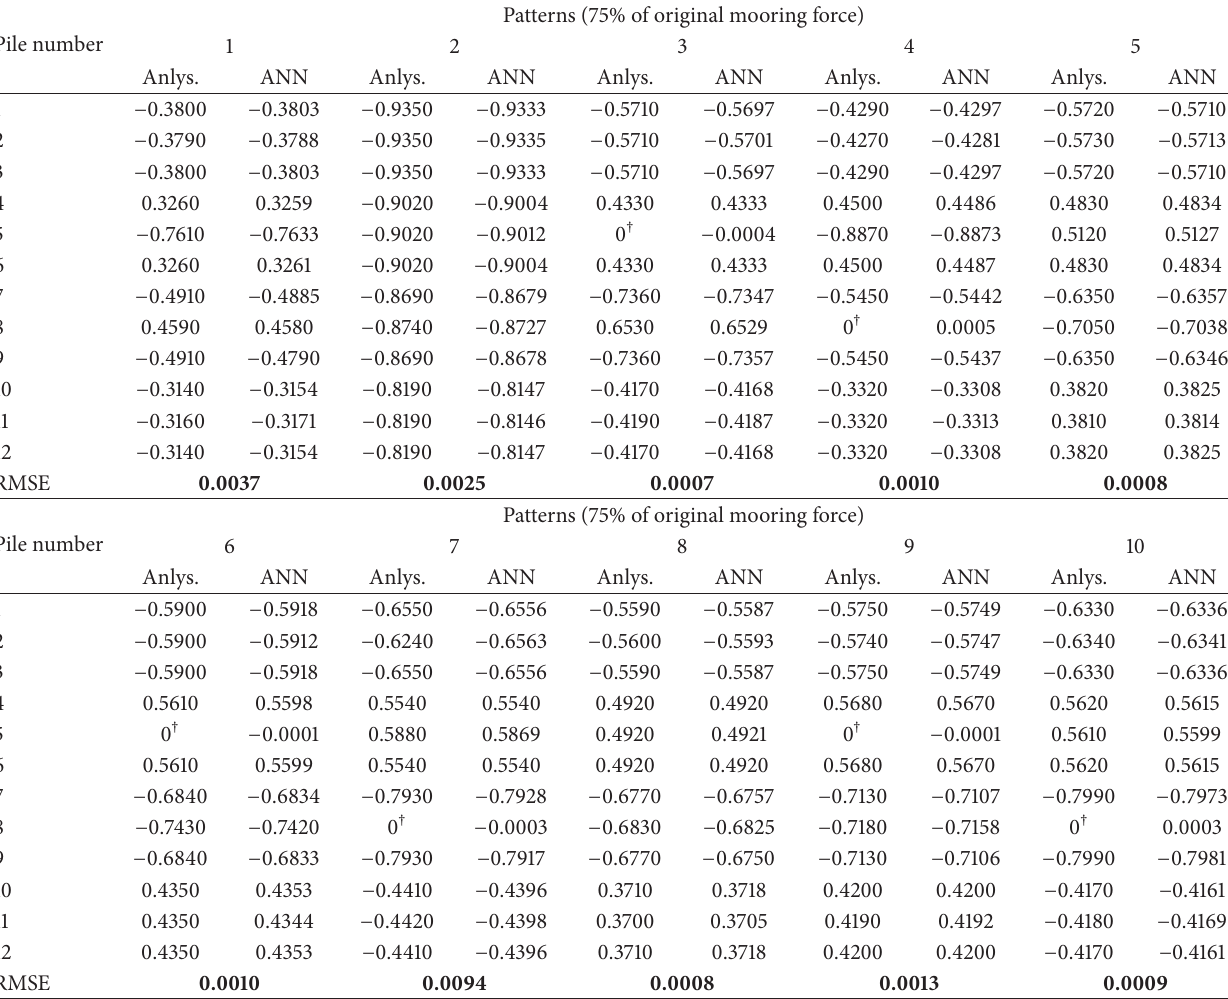
Table 9: Comparison of stress ratios obtained by MBPNN and FE